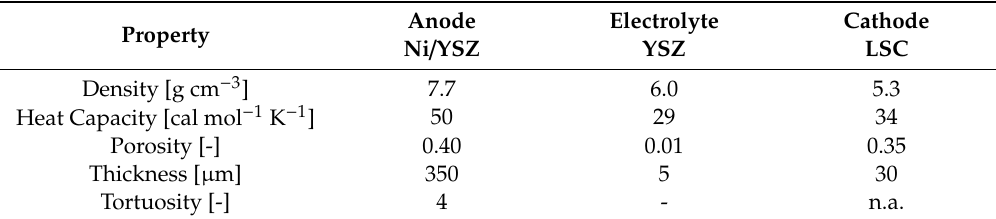
Table 3. Physical and microstructure properties of di ff erent cell layers.